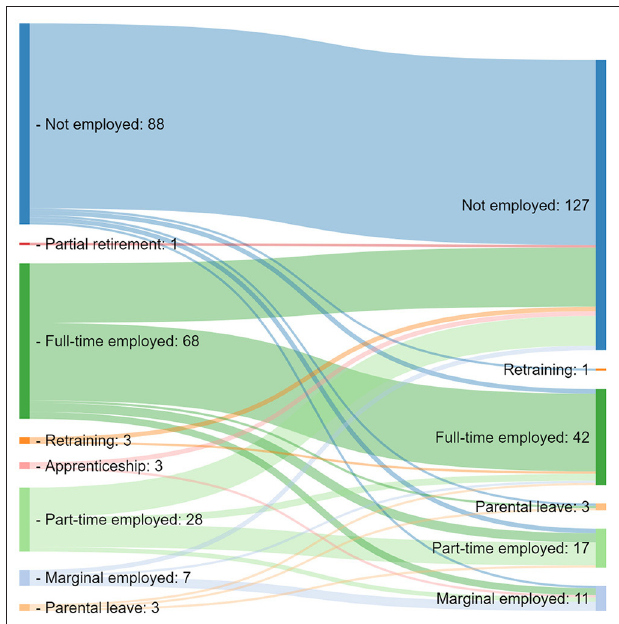
FIGURE 2 | Sankey chart of changes in employment from diagnosis to study visit.